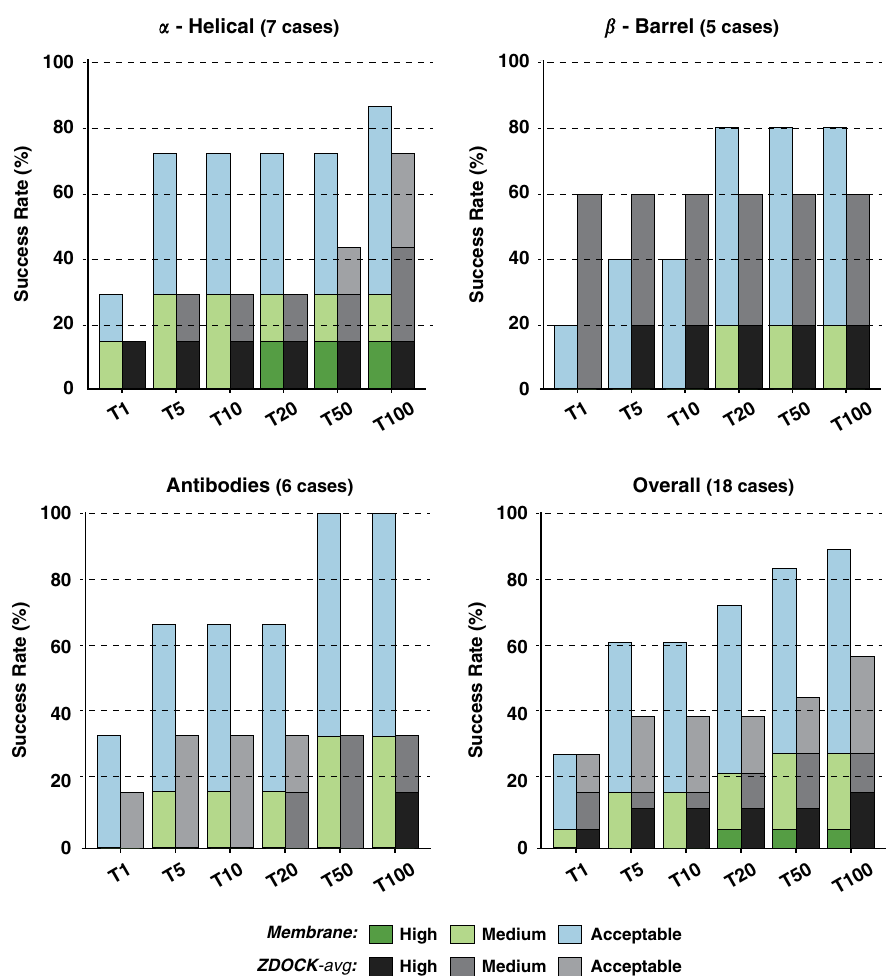
Fig. 6 Performance of the membrane integrative modeling protocol compared to the best ZDOCK scenario. Success rates are presented for each of the benchmark categories ( α -Helical, β -Barrel and Antibodies) as well as overall (including all three different categories) for the membrane protocol (Membrane, color coding from blue to green) and the best ZDOCK scenario (ZDOCK-avg, grayscale) on the 18 cases of the membrane docking benchmark. The color coding/grayscale indicates the model quality (from acceptable to high) according to CAPRI criteria. Source data are provided as an excel fi